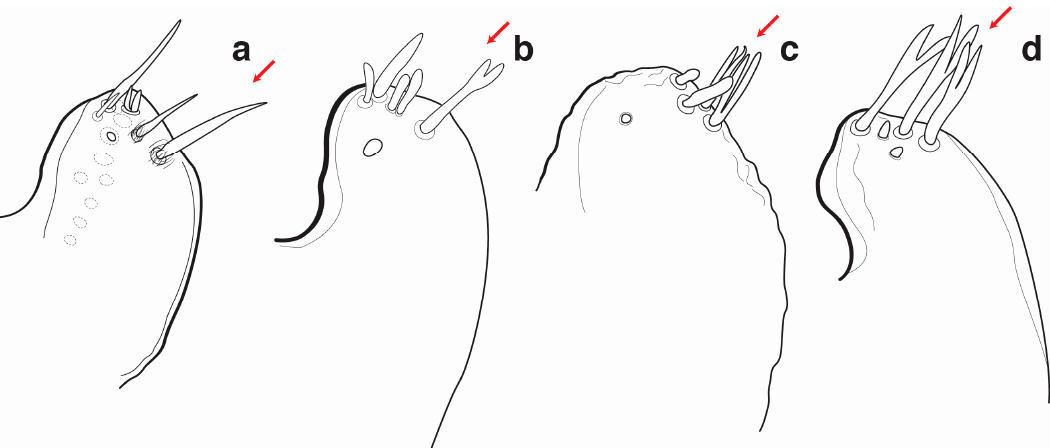
Figure 49. Mala, larva, dorsal view: ( a ) Cosmopolites ; ( b ) Polytus; ( c ) Sipalinus; and ( d Nassophasis .